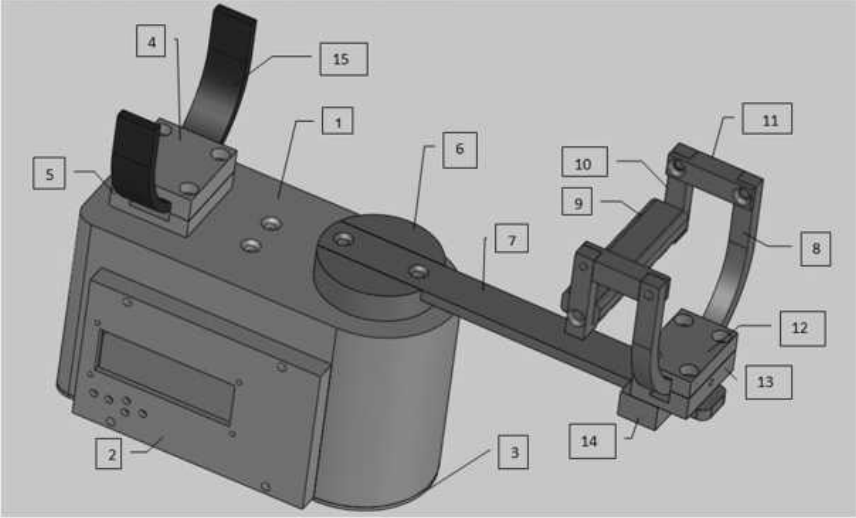
Figure 2. 3D design of the robot.